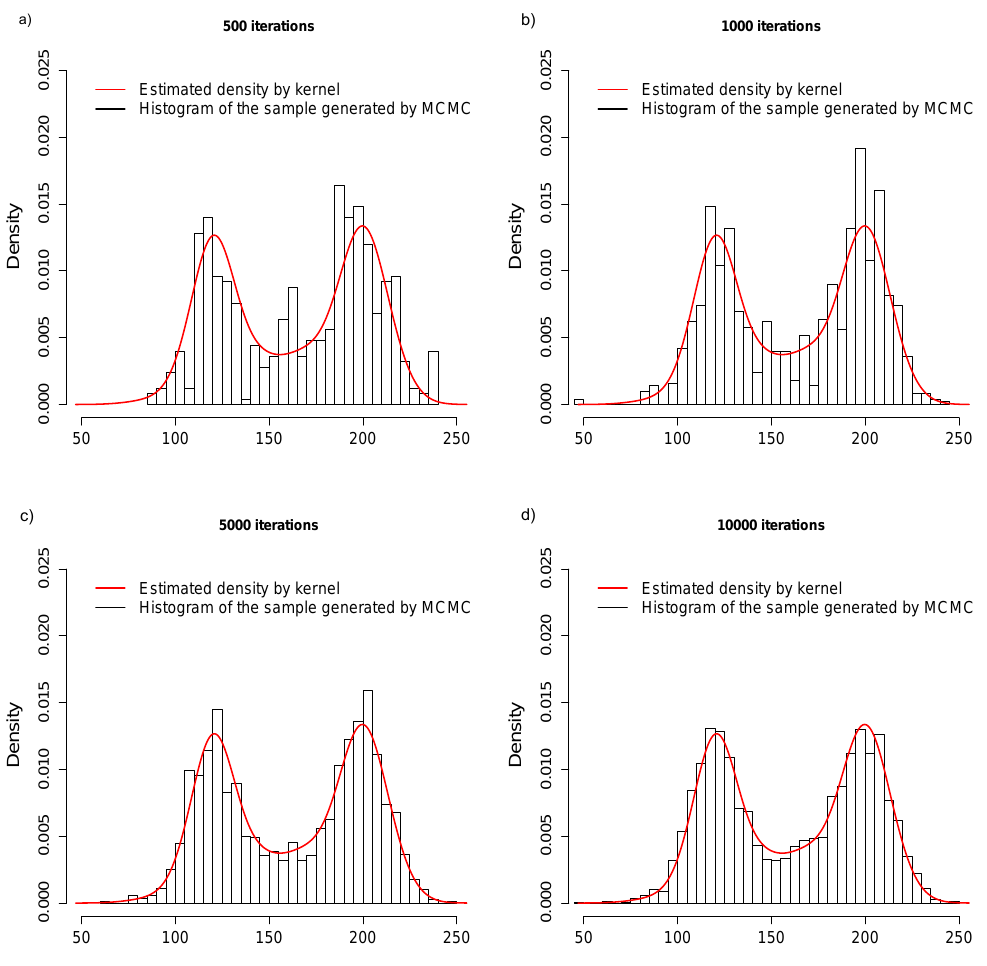
Figure 8. Histograms of the samples generated by the MCMC from the density obtained by the kernel method: ( a ) 500 iterations. ( b ) 1000 iterations. ( c ) 5000 iterations. ( d ) 10,000